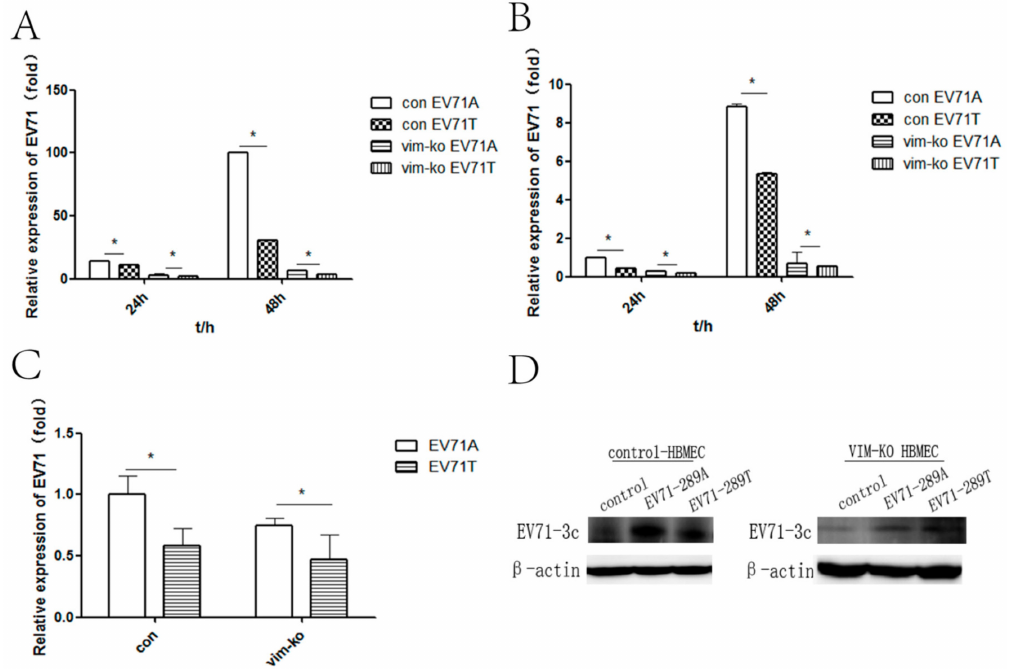
Figure 2. Viral Kinetics of EV-A71-289A and EV-A71-289T in control human brain microvascular endothelial cells (HBMECs) and VIM-KO HBMECs. Control HBMECs and VIM-KO HBMECs